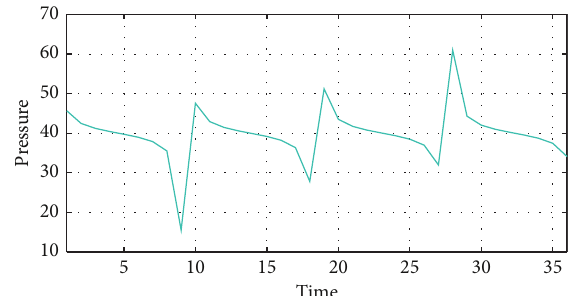
Figure 4: Hydrodynamic simulation